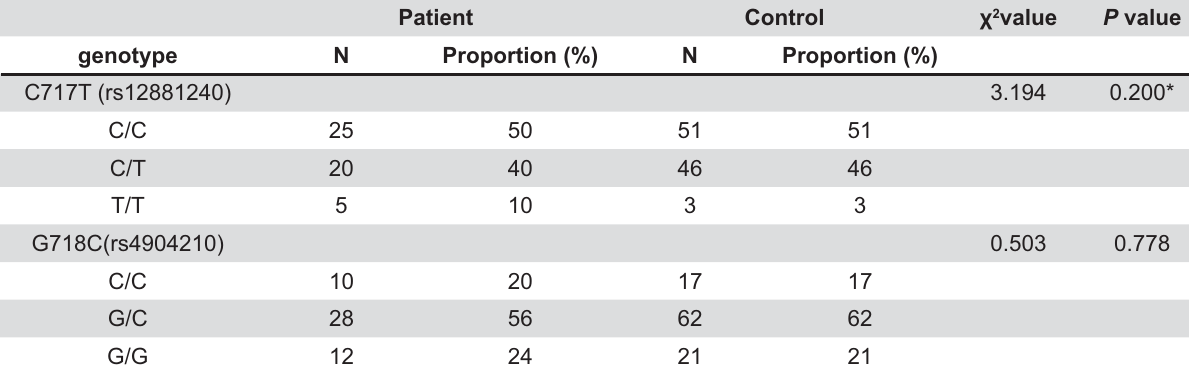
Table 2- Difference analysis of gene frequency (the differences of two constituent ratio analysis, conducting chi-square statistics) Sample size: